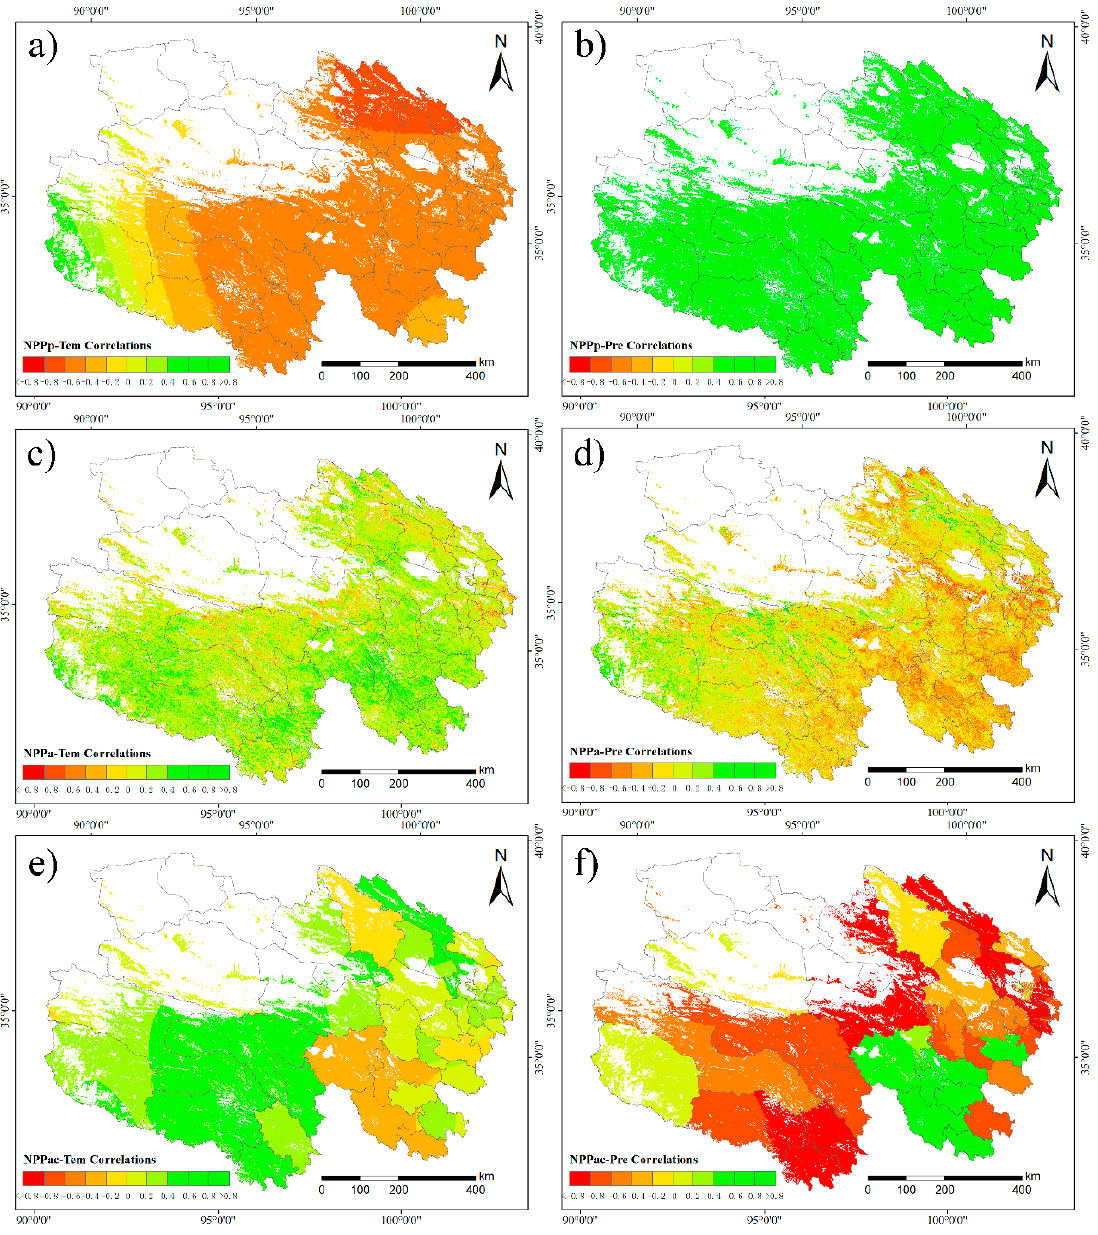
Figure 6. Correlations of NPP p , NPP a , and NPP ac with climate in alpine grassland in Qinghai Province from 2005 to 2018: ( a ) correlation coefficient between NPP p and temperature; ( b ) correlation coefficient between NPP p and precipitation; ( c ) correlation coefficient between NPP a and temperature; ( d ) correlation coefficient between NPP a and precipitation; ( e ) correlation coefficient between NPP ac and temperature; ( f ) correlation coefficient between NPP ac and precipitation.